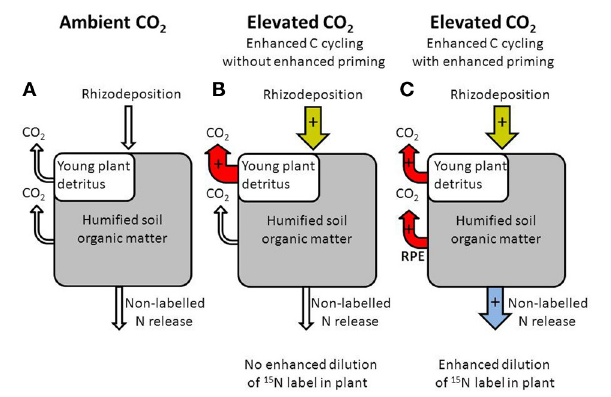
FIGURE 4 | Diagram illustrating the role of rhizodeposition for carbon cycling under ambient (A) and elevated CO 2 (B,C). An increase in rhizodeposition under elevated CO 2 can enhance the decomposition of young plant detritus only without affecting the decomposition of humified SOM and without affecting the release of non-labeled nitrogen (B) , or can enhance the decomposition of plant detritus and humified SOM (rhizosphere priming effect or RPE) thereby increasing release of non-labeled nitrogen (C)